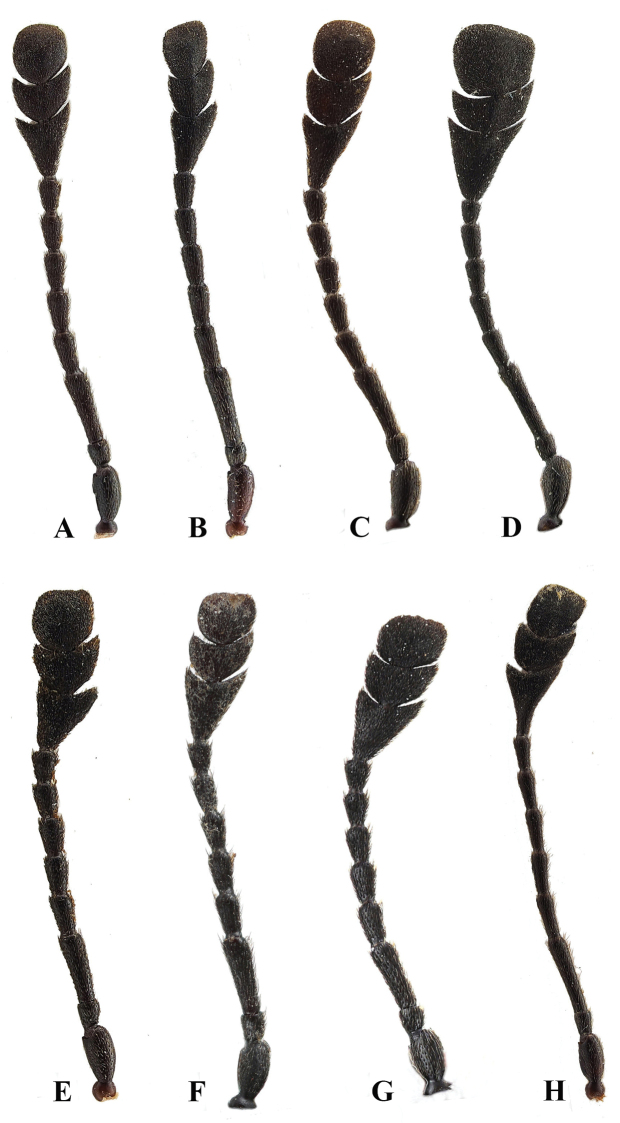
Left antenna of Sinocymbachus spp. (dorsal view) AS.
angustefasciatusBS.
bimaculatusCS.
decorusDS.
excisipesES.
humerosusFS.
luteomaculatusGS.
parvimaculatusHS.
quadrimaculatus.